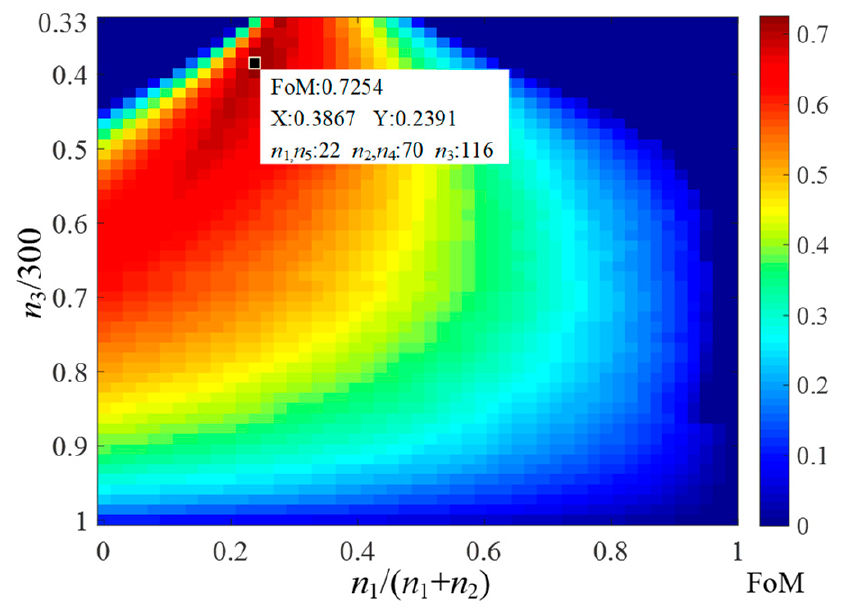
Figure 6. Variation in MF performance of the five-section STC with different winding parameters.